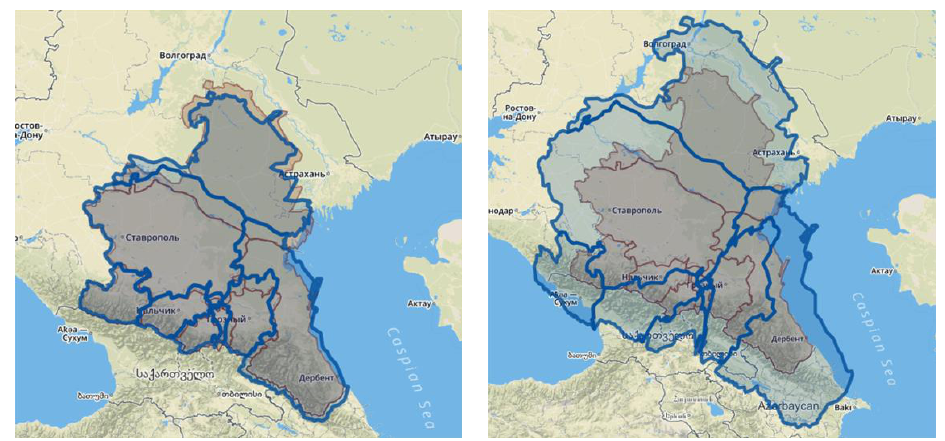
Fig. 11. Anamorphosis of per capita income and anamorphosis of the integral indicator (per capita income and population growth) in